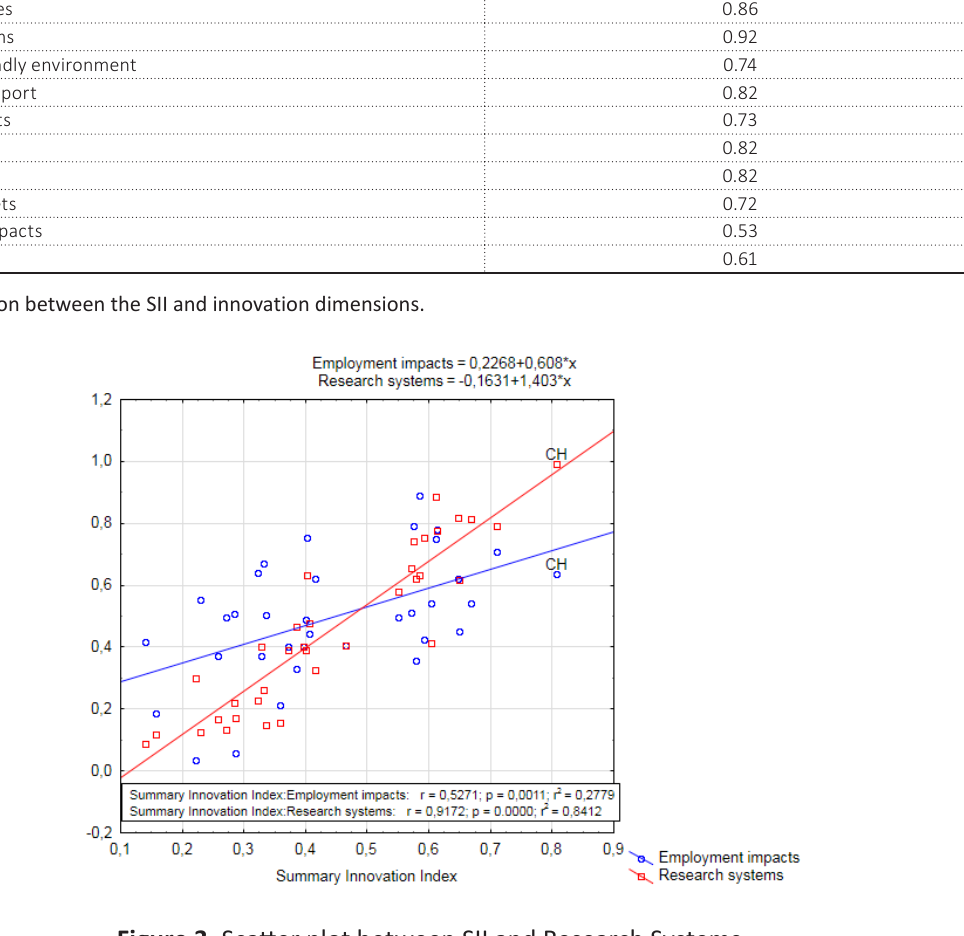
Figure 3. Scatter plot between SII and Research Systems